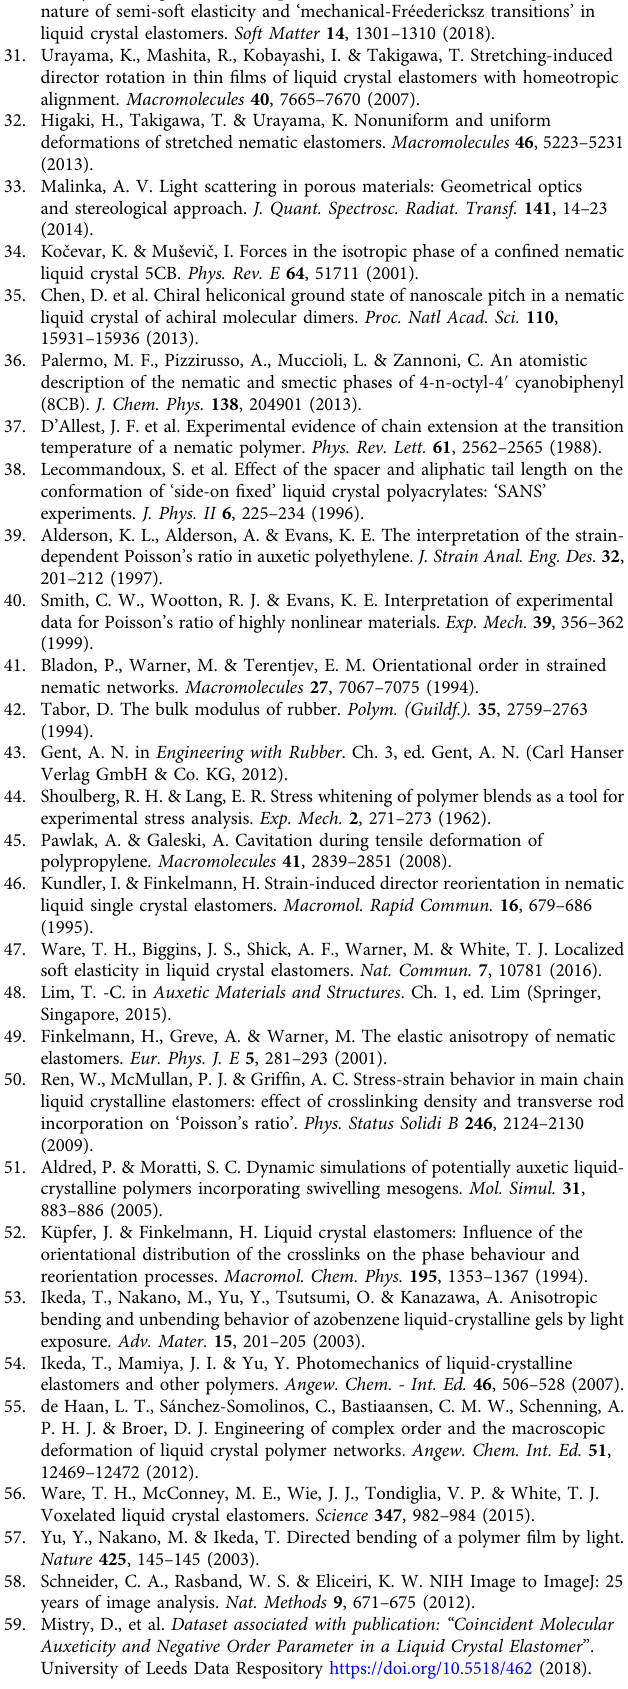
Data availability Source data fi les, plotting fi les, original AFM and SEM images and fi gure gen- eration fi les are available at [https://doi.org/10.5518/462]. Raw data can be obtained from the authors upon reasonable request 59